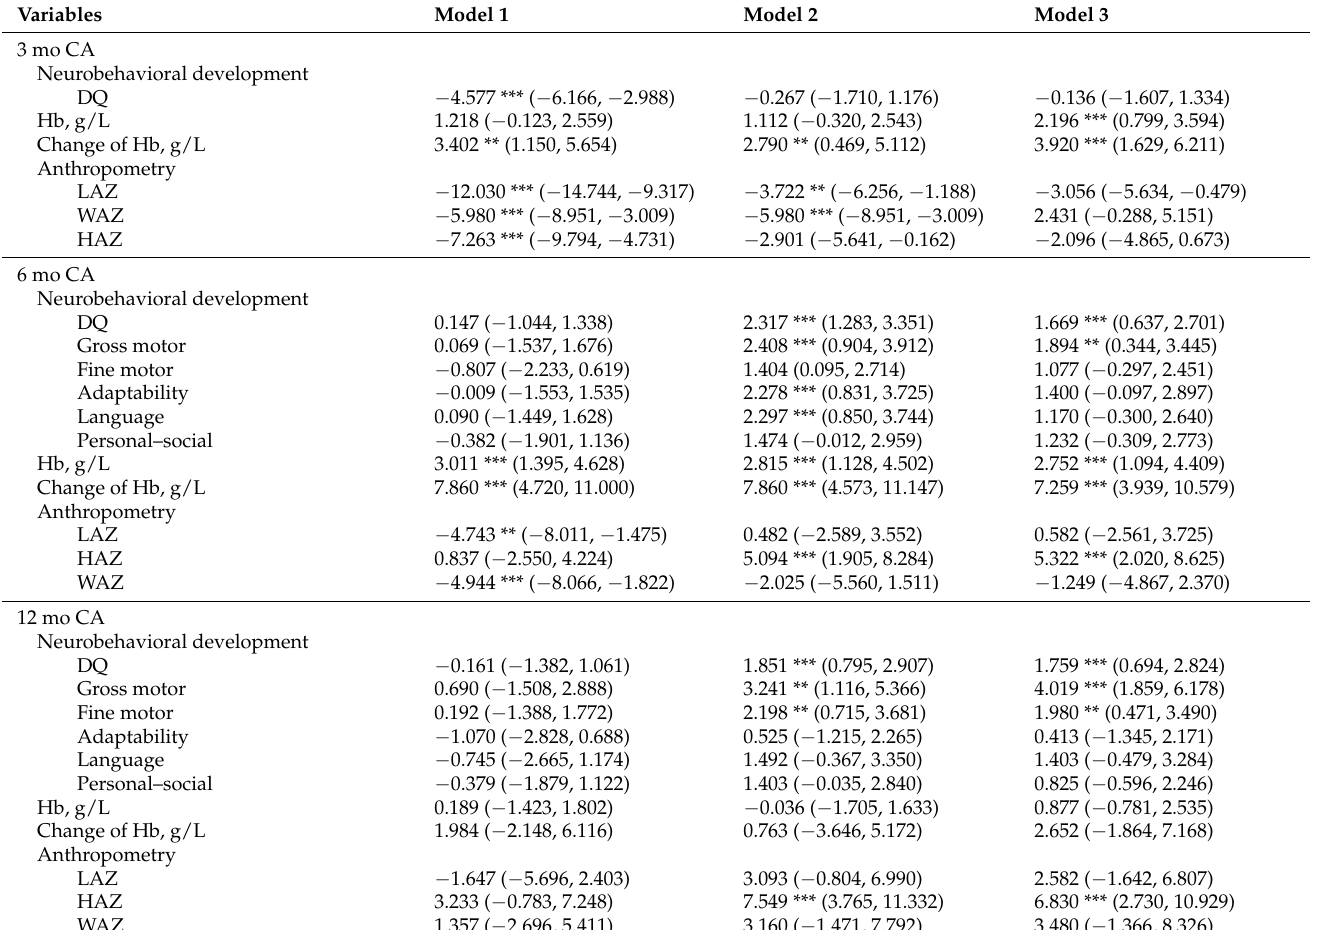
Table 3. The associations between iron supplementation with neurobehavioral development, Hb, and anthropometry in premature infants at 3, 6, and 12